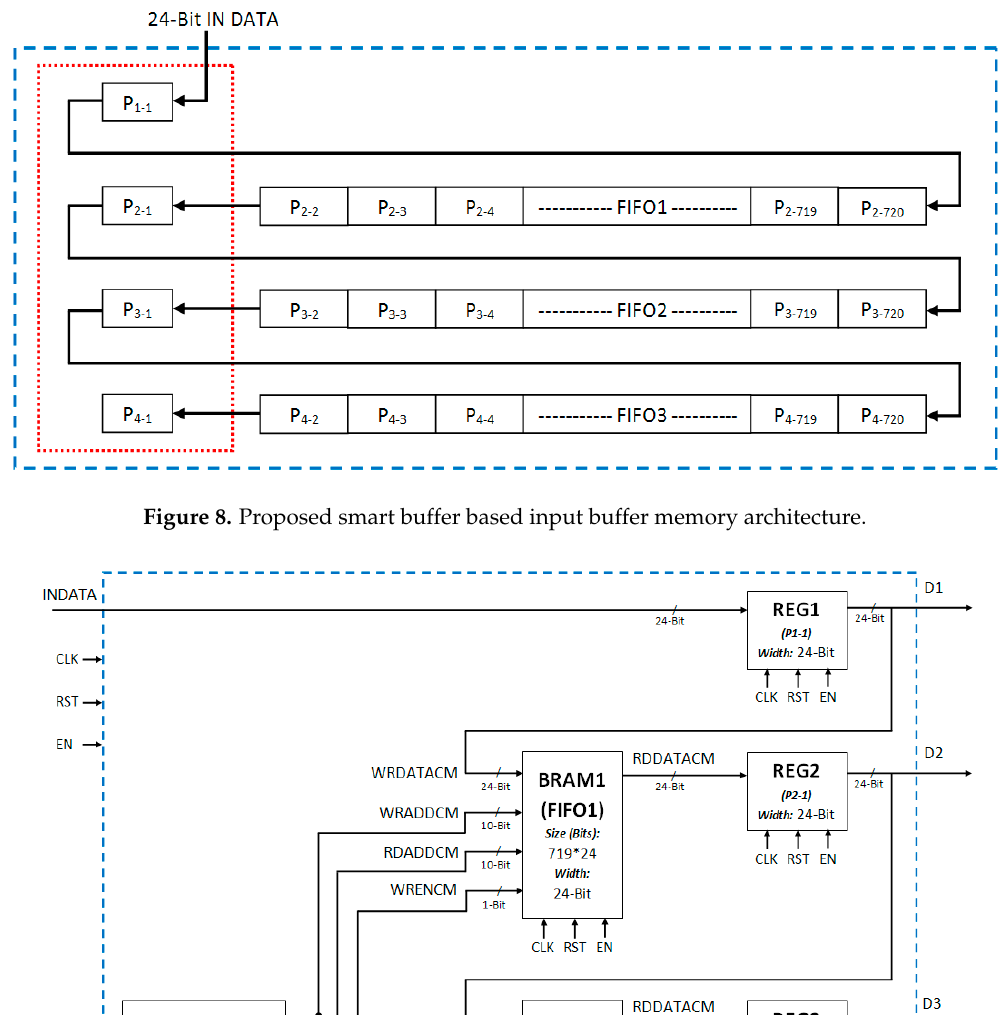
Figure 9. Detailed implementation of input buffer memory architecture using block RAMs and registers.